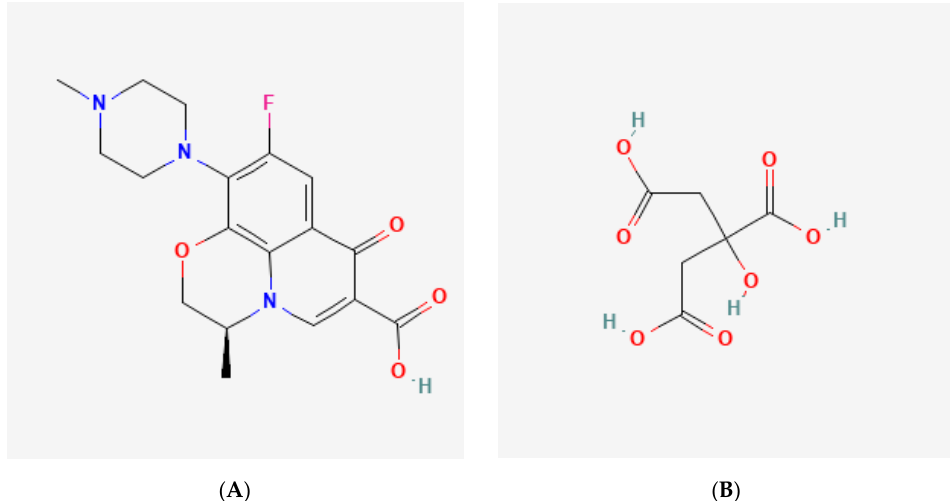
Figure 1. Molecular structure of parent compounds: ( A ) levofloxacin (LF) [13] and ( B ) citric acid (CA) [14].